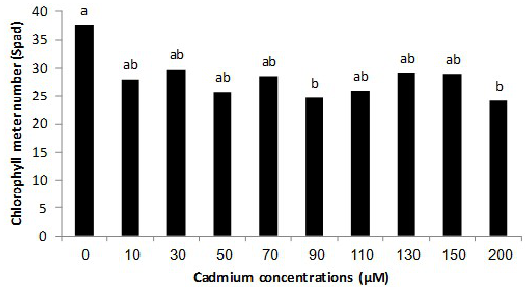
Fig. 6. Effects of cadmium on root dry weight of Brassica napus L.